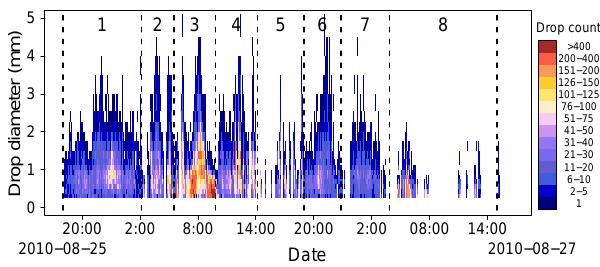
Figure 4. DSD during the rain event. The black dashed lines illus- trate the identified rain episodes of the